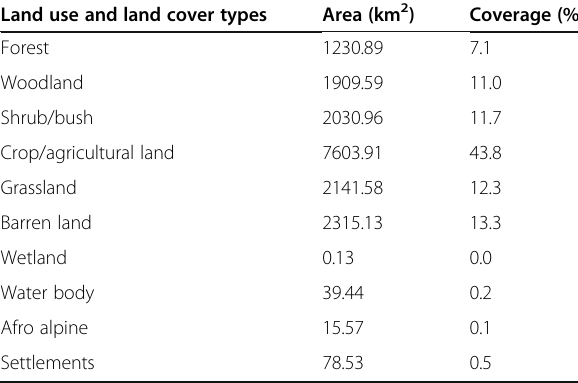
Table 1 The land use and land cover type classification and area coverage of the study